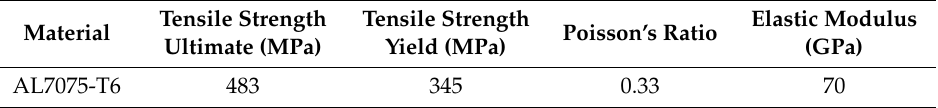
Table 1. The main properties of the aluminum alloy 7075-T6.